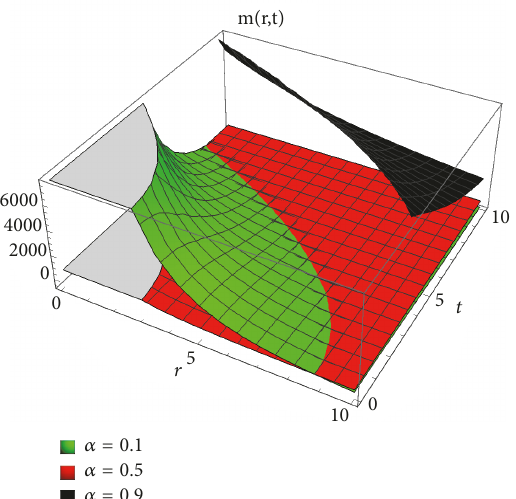
Figure 4: Mass plot along 𝑟 and 𝑡 for 𝑘 = 2.5 and the different values of 𝛼 .